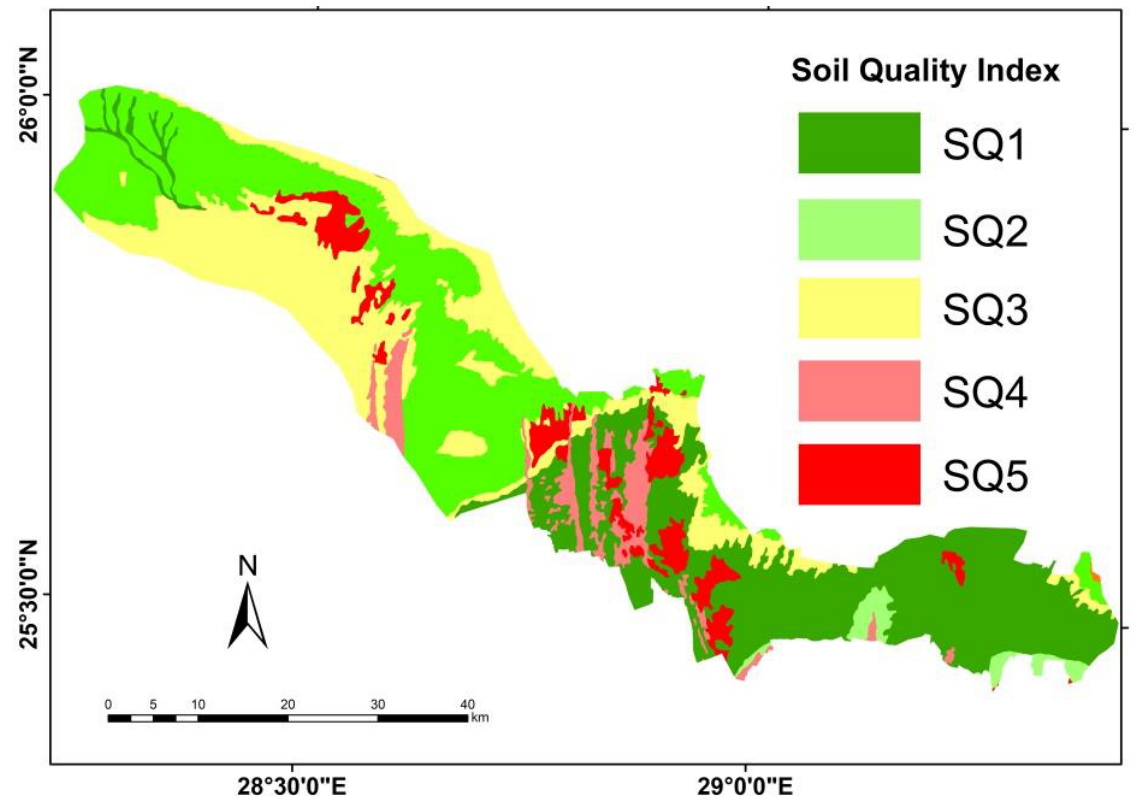
Figure 9. Soil quality categories of the study area.